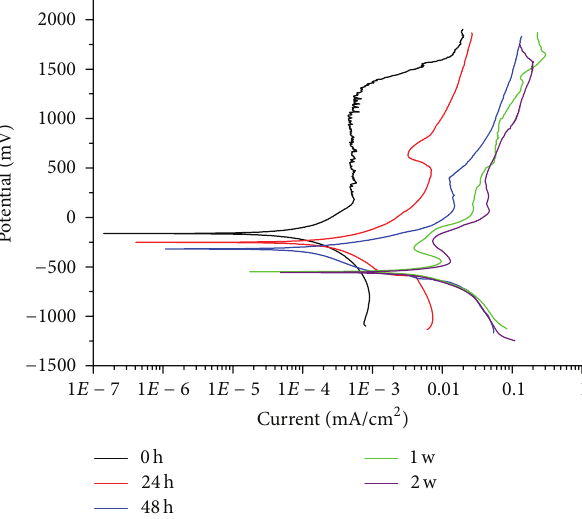
Figure 7: Polarization curves of ABS-3 copper coupon in Na 2 SO 4 + 3 wt% NaCl solution in